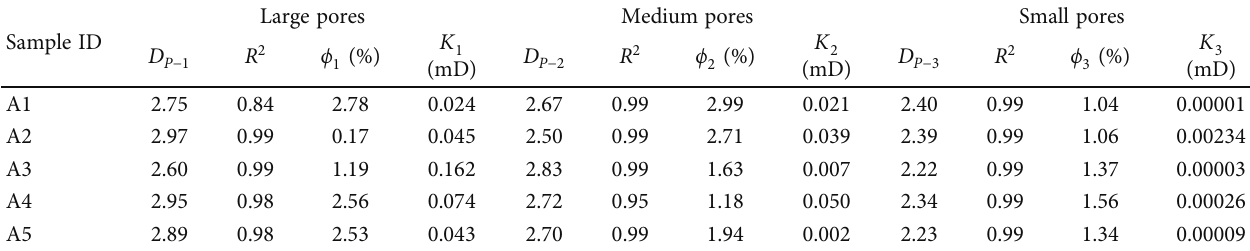
sublayer, Yanchang Formation. 3